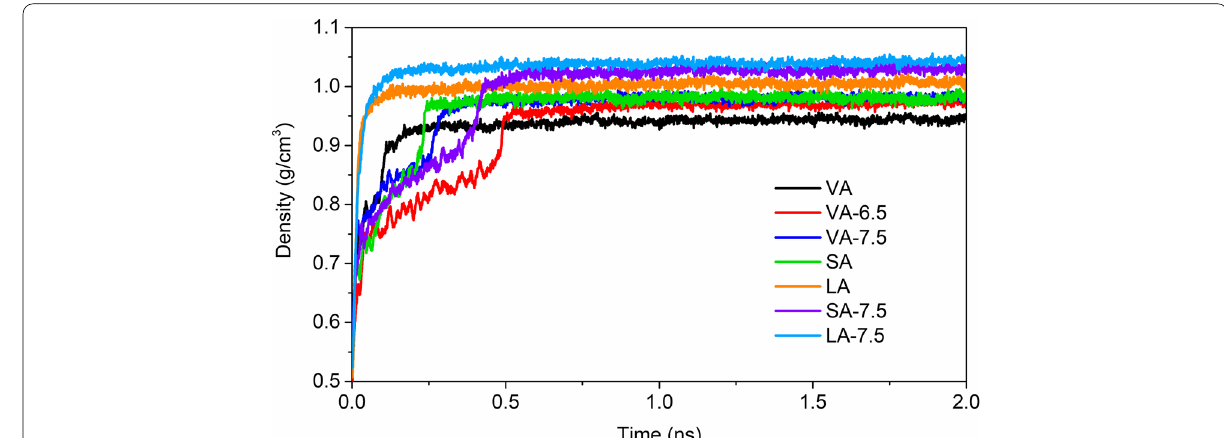
Fig. 13 Model Density Changes during Self-Healing Process at 333 K